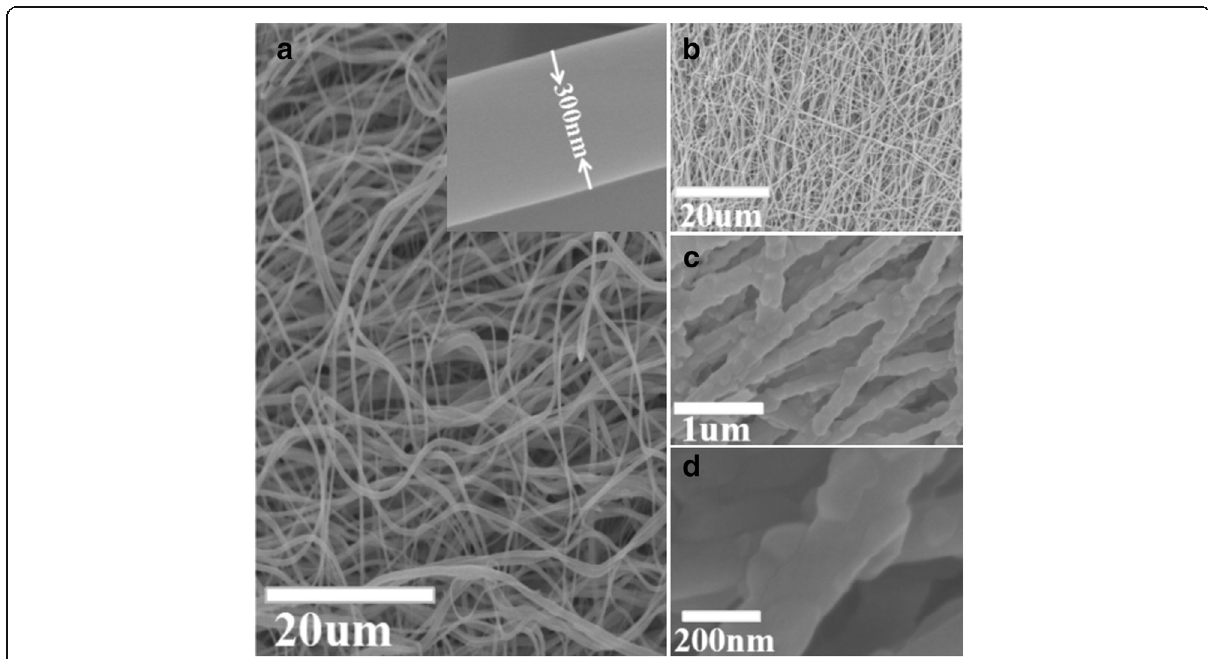
Fig. 3 FESEM image of ST-3. a as-prepared ST-3, inset : High magnification SEM (unsintered), ( b )-( d ) ST-3 (sintered)